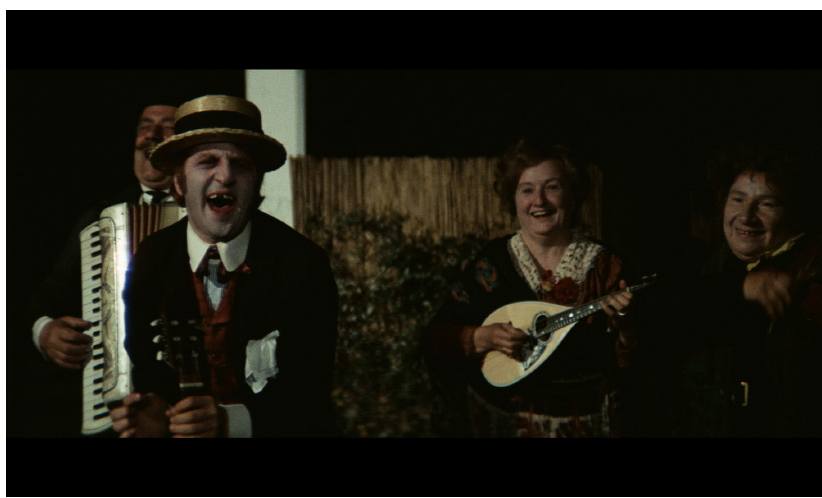
Fig. 5 Visconti, Death in Venice , mocking of the